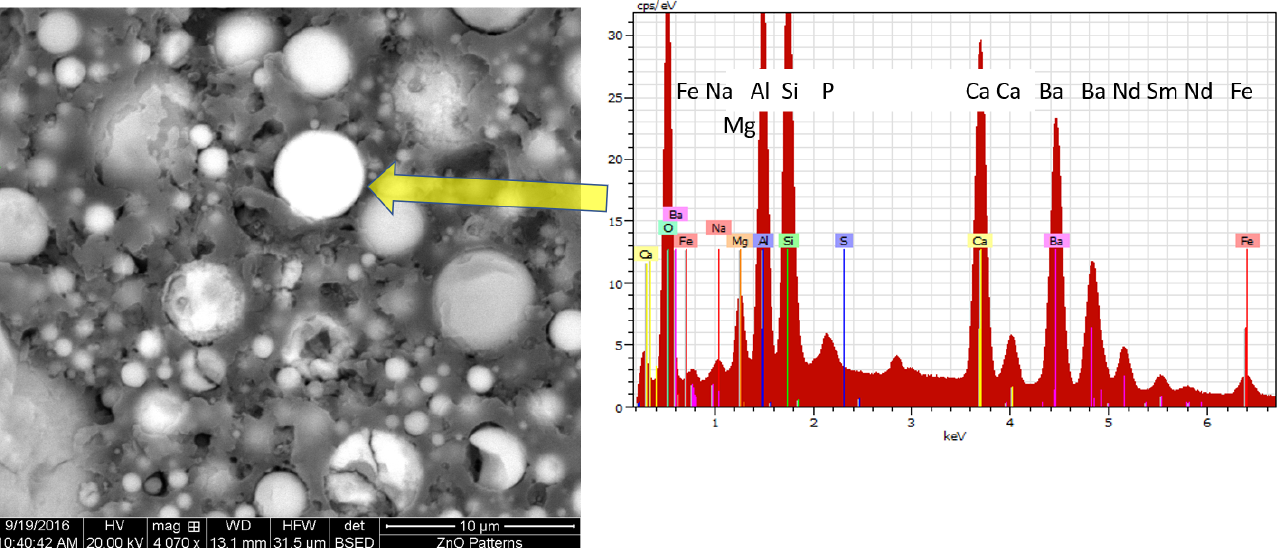
Figure 4. Back-scatter image of a large swath of the epoxy-bound pellet. Scale = 10 µ m.